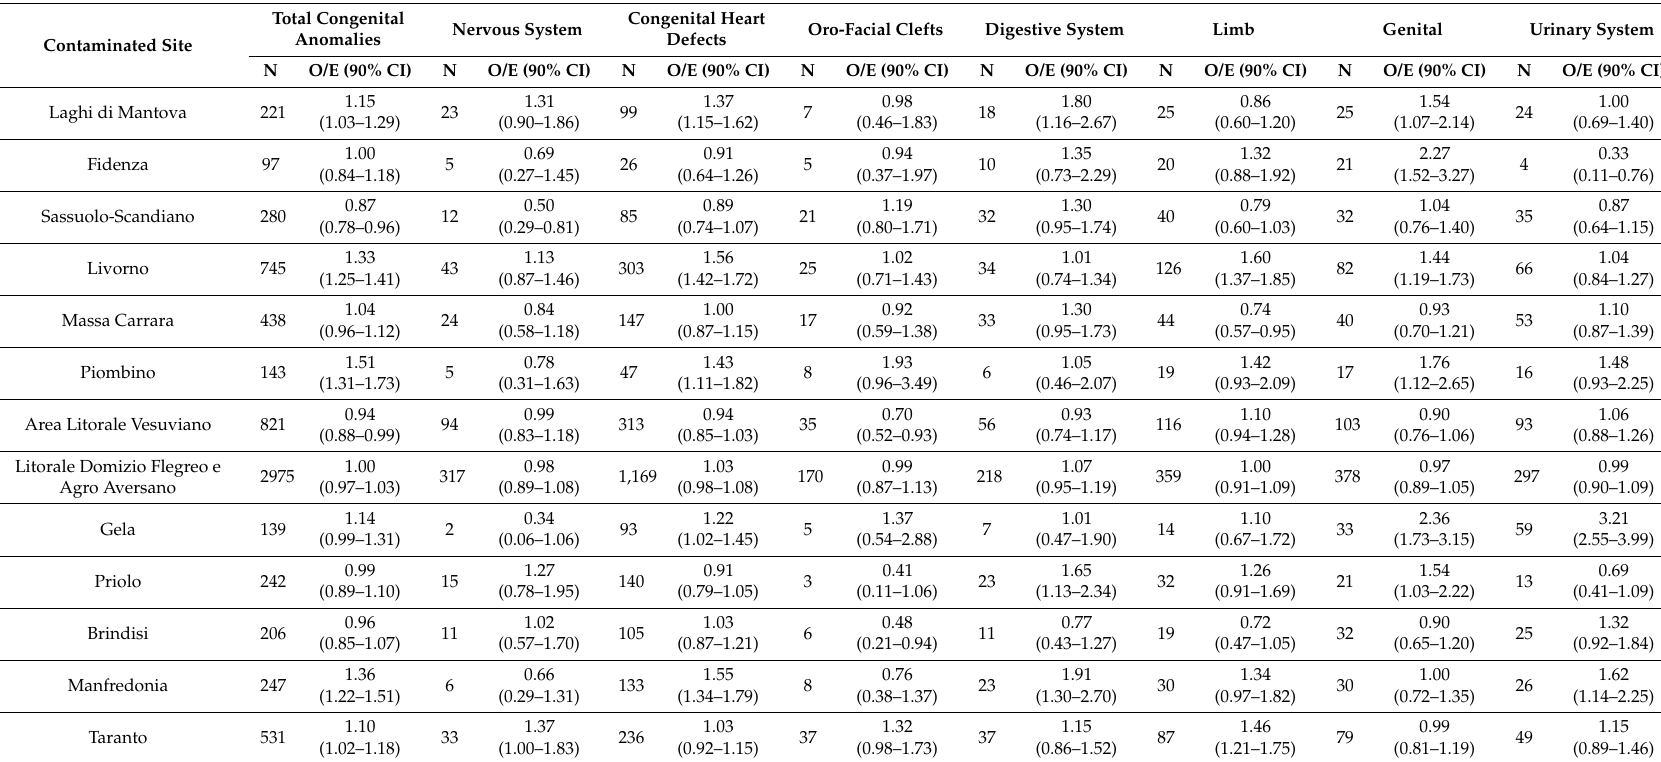
Table 2. Number of cases (N), observed/expected ratio (O/E) with 90% confidence interval (90% CI) by contaminated site and subgroup of congenital